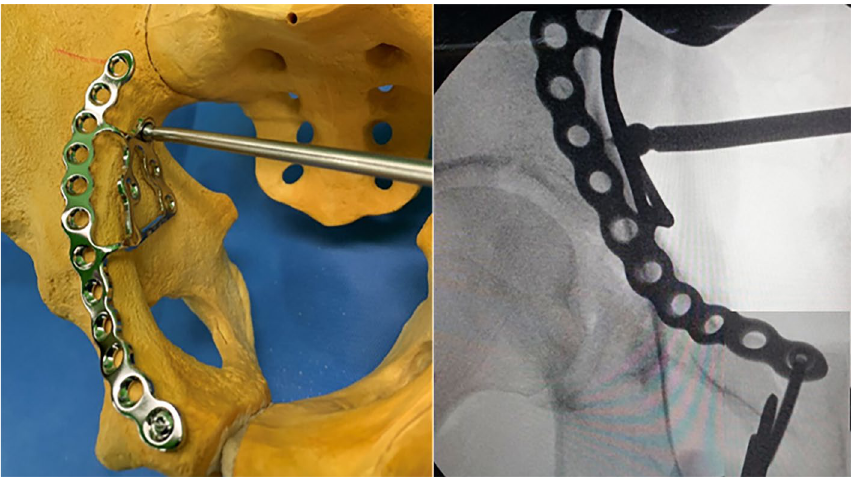
Figure 4. Indirect reduction of the medially displaced posterior column fragment using a ball spike pusher on the infrapectineal portion of the quadrilateral surface plate.